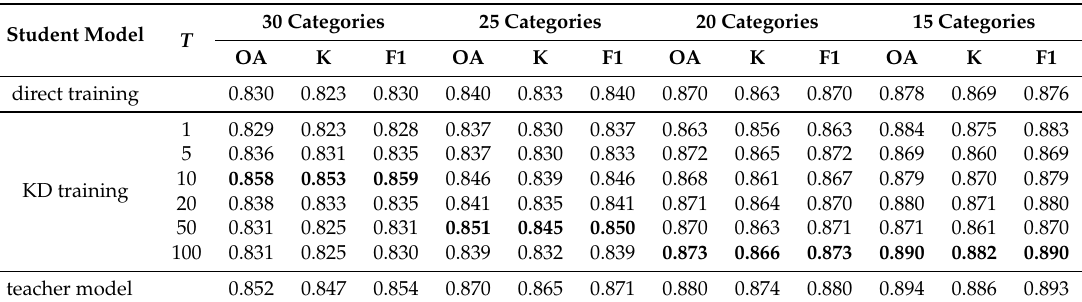
Table 6. Results of Knowledge Distillation training experiments with different numbers of category and temperatures on AID